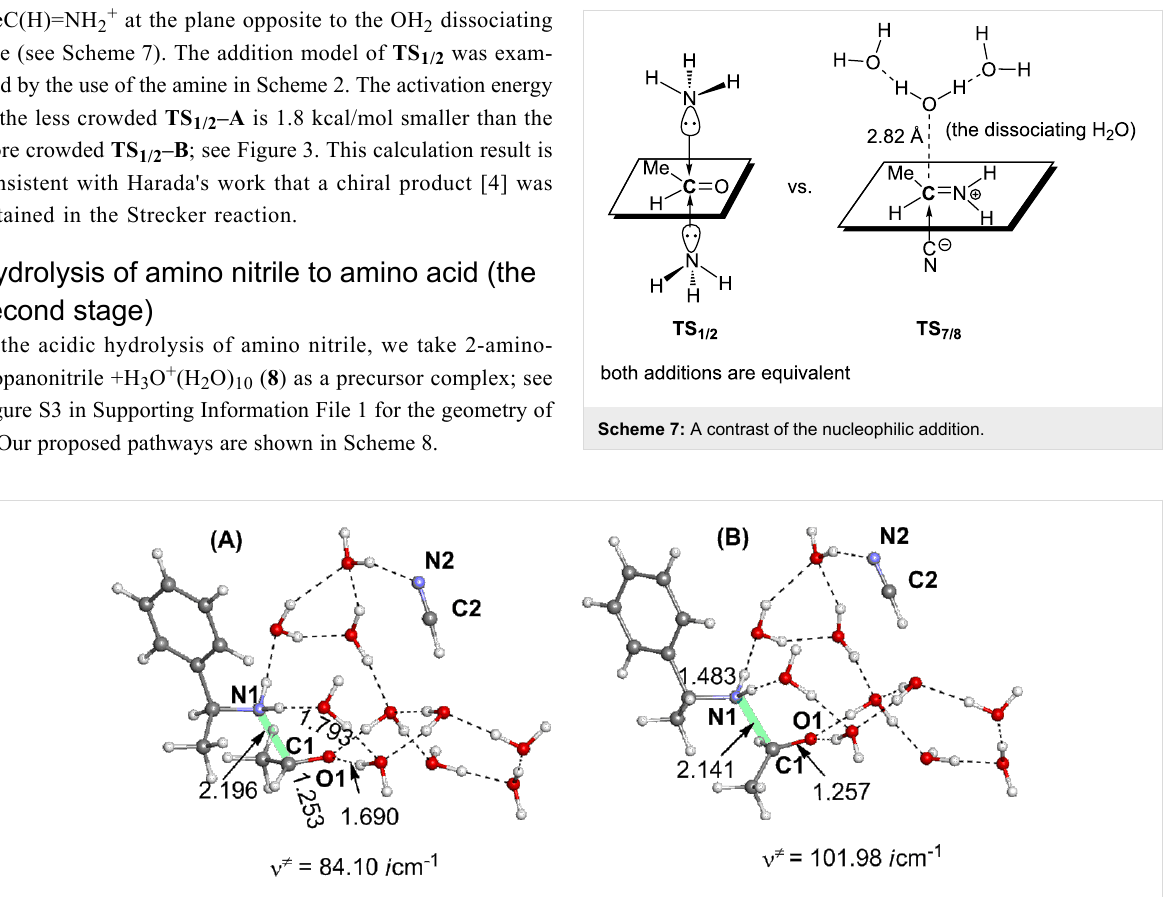
Figure 2: Energy changes along elementary processes from acetaldehyde to aminonitrile. Bold numbers are defined in Scheme 5.